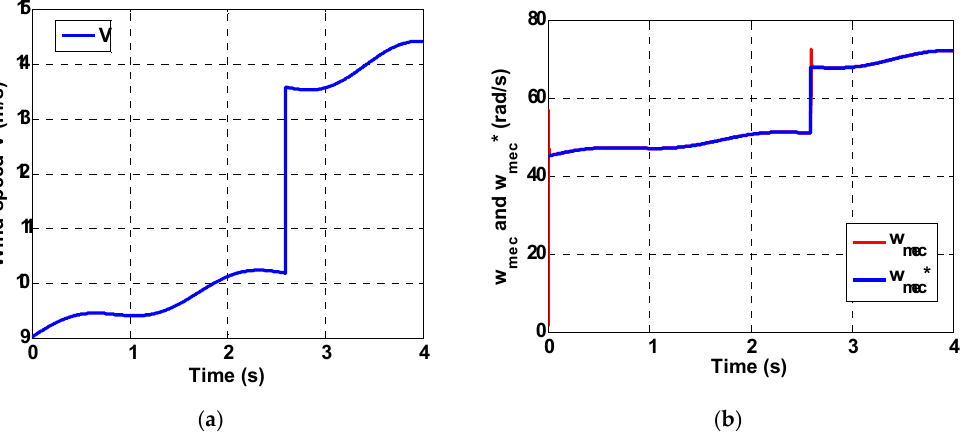
Figure 12. Developed FTC-performance of the wind turbine system driven IG with ITSC fault of 30% of s 1 -phase under 50% increase in both stator and rotor resistance values at t = 1.5 s and then under a sudden wind speed variation at t = 2.6 s: ( a ) wind speed V and ( b ) mechanical speed ω mec and its reference ω mec * .